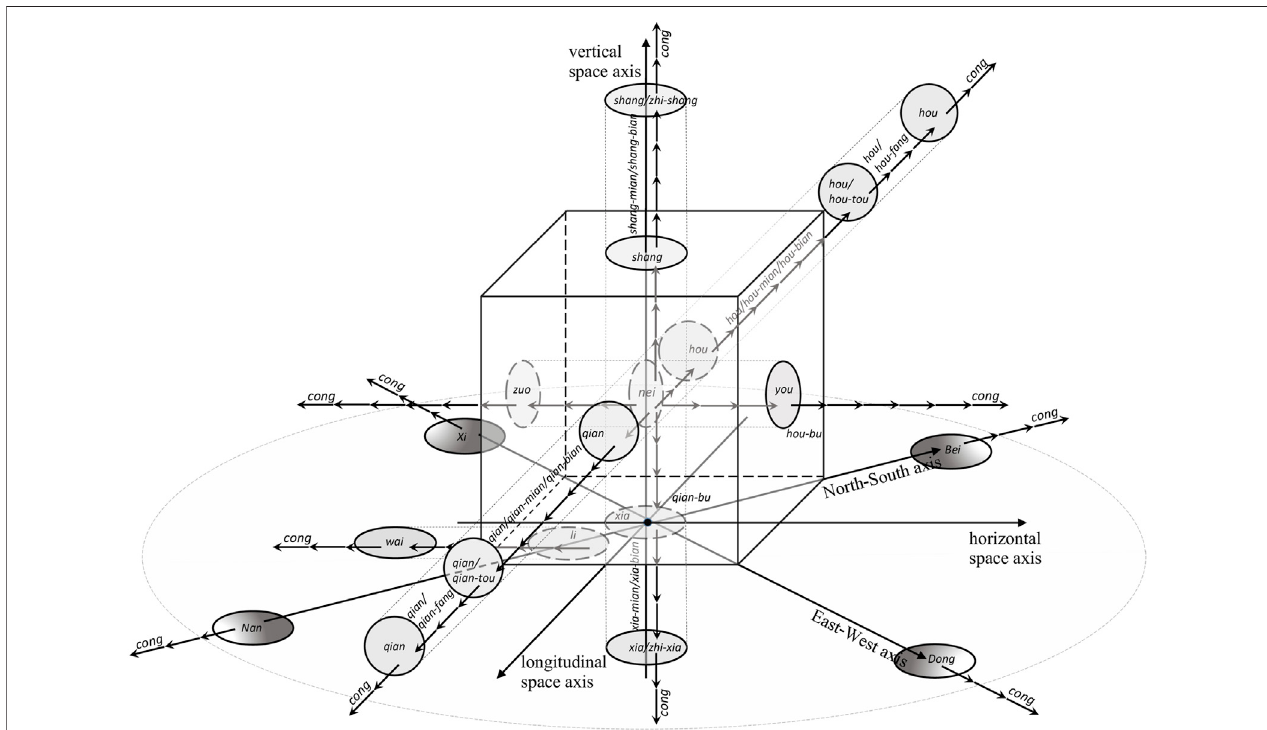
FIGURE4| Thesemanticmapfor cong .Themaprepresents cong ’ shaloindirectly:allthepathsleavingtheground,orlocations/regionsde fi nedwithrespecttothe ground,arepartoftheregionthat cong covers.Thisentailsthatwhensentencesdescribeformsofdirectedmovement,theycanlacklocalisers.Thisisthecasebecause cong can refer to the location that a fi gure reaches as one of the possible “ sources ” of the fi gure.